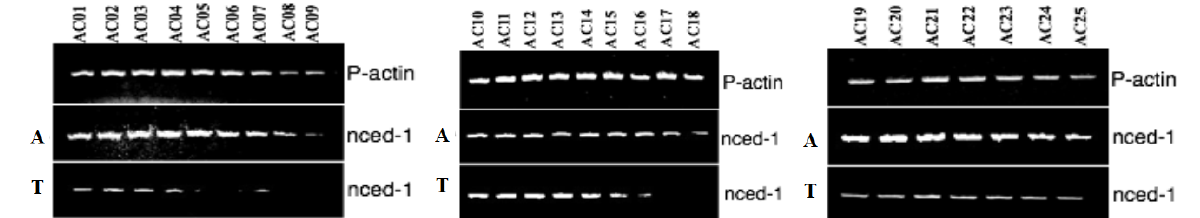
Fig. 2. Gel image of expression patterns of NCED1 and P-Actin genes for accessions of cowpea under control (A) and drought-stressed (T) conditions. P-Actin gene was used as the internal control. AC01 – AC25 are accessions of